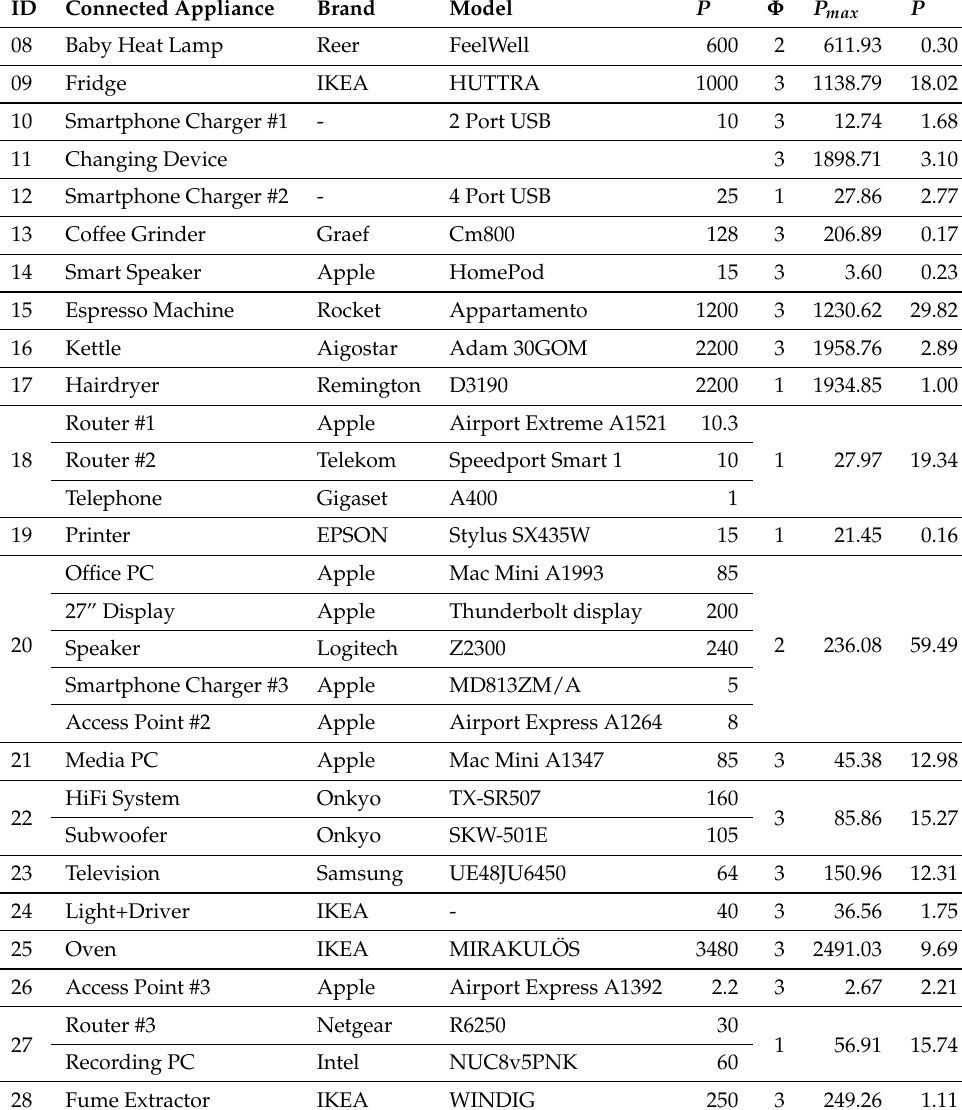
Table 2. Appliances recorded via PowerMeters. ID represents the identifier of the PowerMeter used for recording. For PowerMeter11 , the connected appliance changed during recording. P is the power according to the device manufacturer, Φ is the Live Wire the device is connected to ( L 1 , L 2 or L 3 ), P max is the maximum average power drawn for the duration of one second and P is the per day average power seen during the recording. The unit of all power measurements is